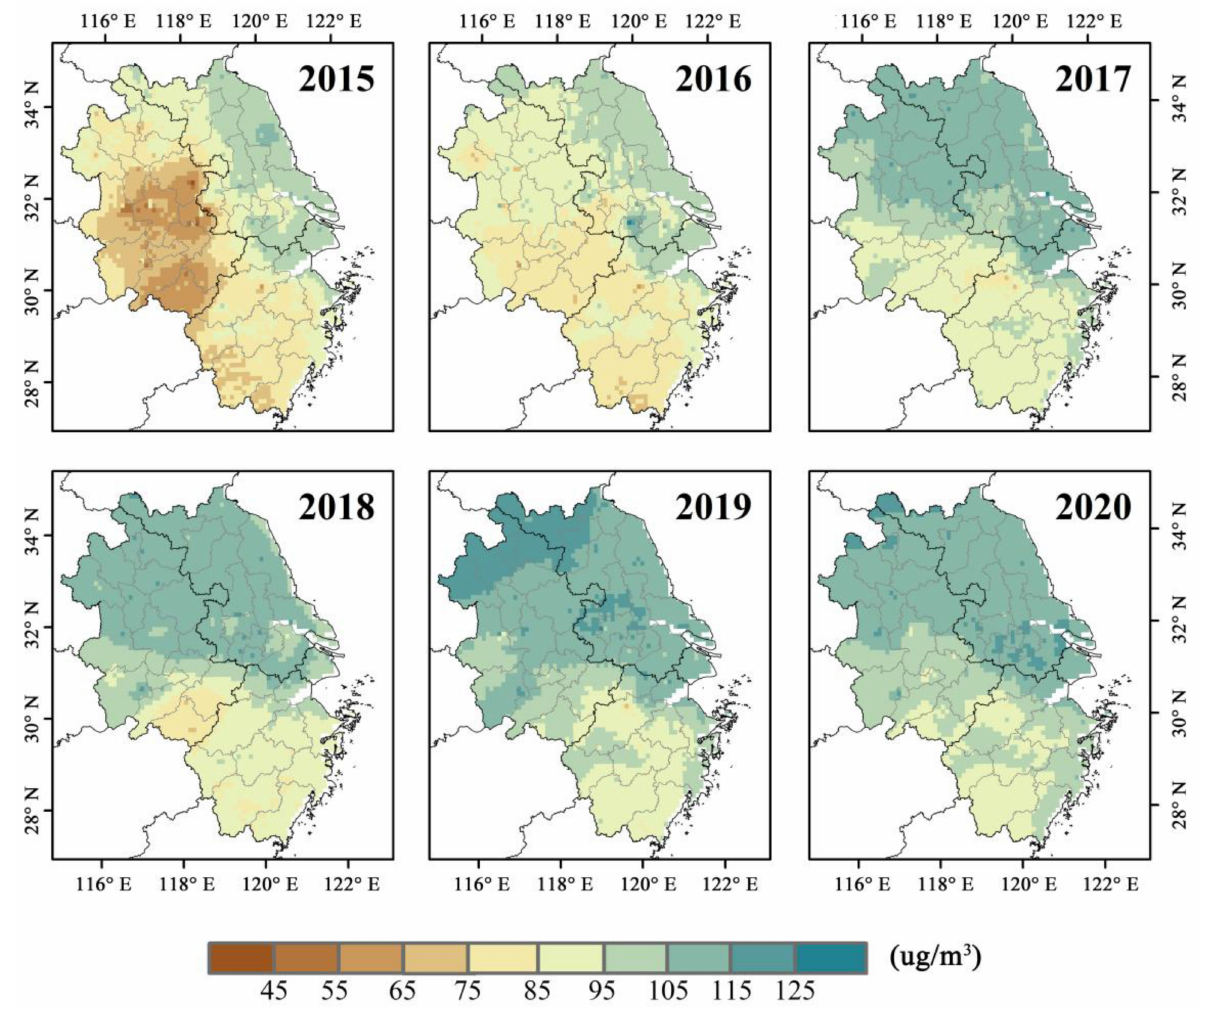
Figure 6. Spatial distributions of annual O 3 concentrations in the YRD from 2015 to